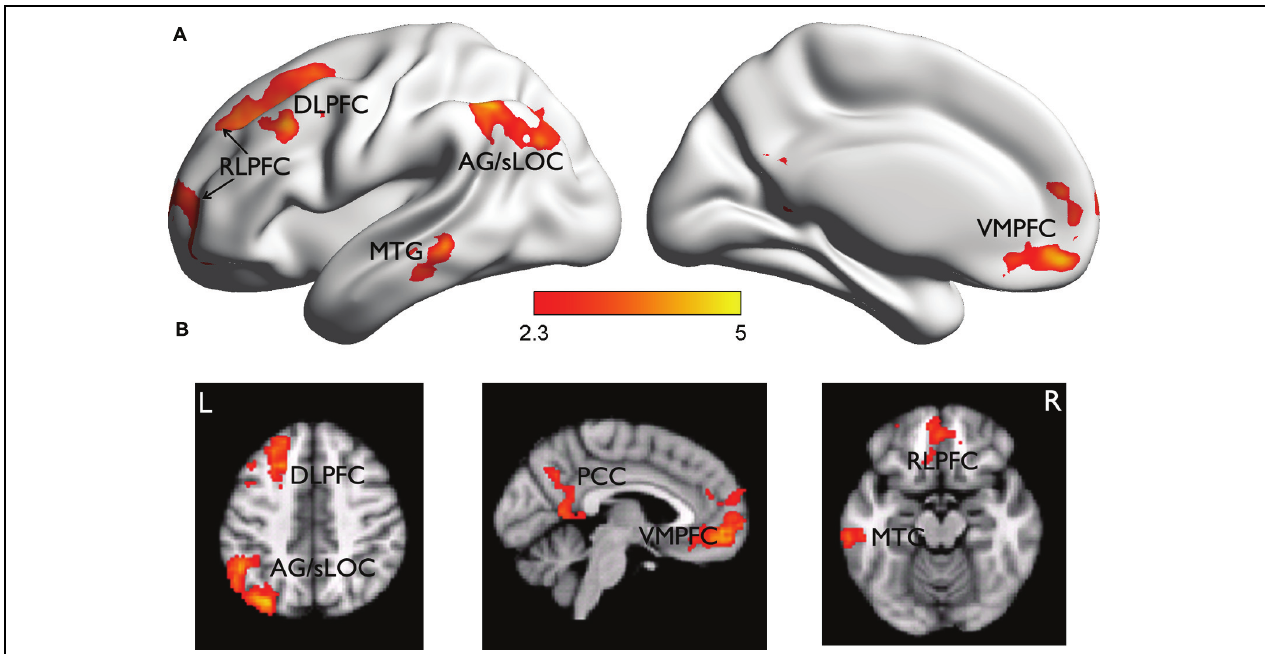
FIGURE 3 | Brain regions related to the subsequent JOL effect. (A) Brian regions showing stronger activity for trials judged as “will be remembered” than those judged as “will be forgotten.” They are rendered onto a population-averaged surface atlas (Xia et al., 2013). (B) The same results are overlain on the axial and sagittal slices of the group mean structural image. All activations were thresholded at Z > 2.3 (whole-brain corrected p < 0.05).